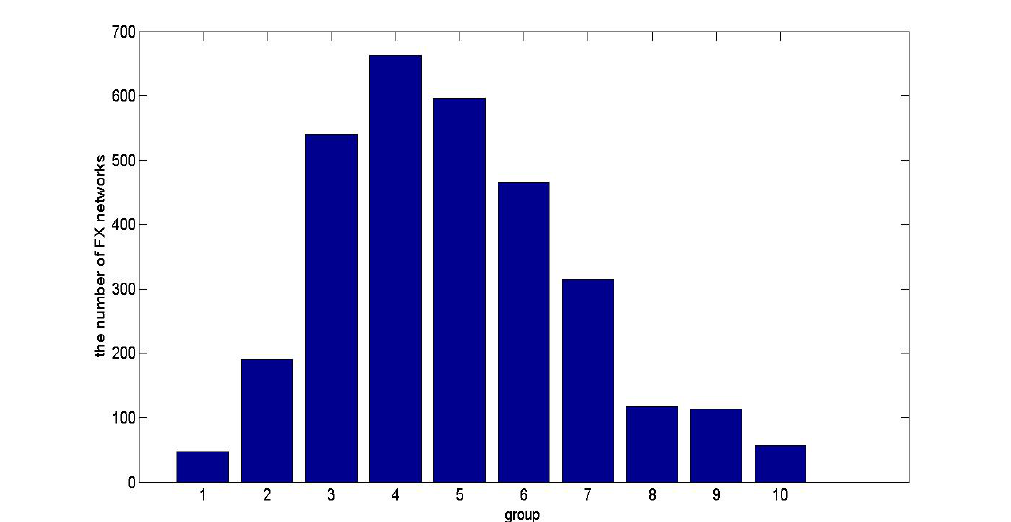
Figure 5. The quantity of FX networks in each group according to the average return of the FX market index with the corresponding time